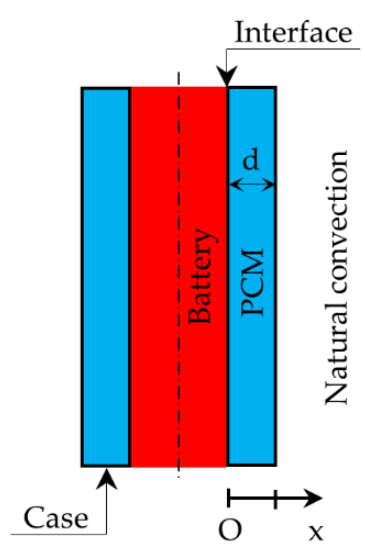
Figure 4. Schematic of the battery and PCM positions.